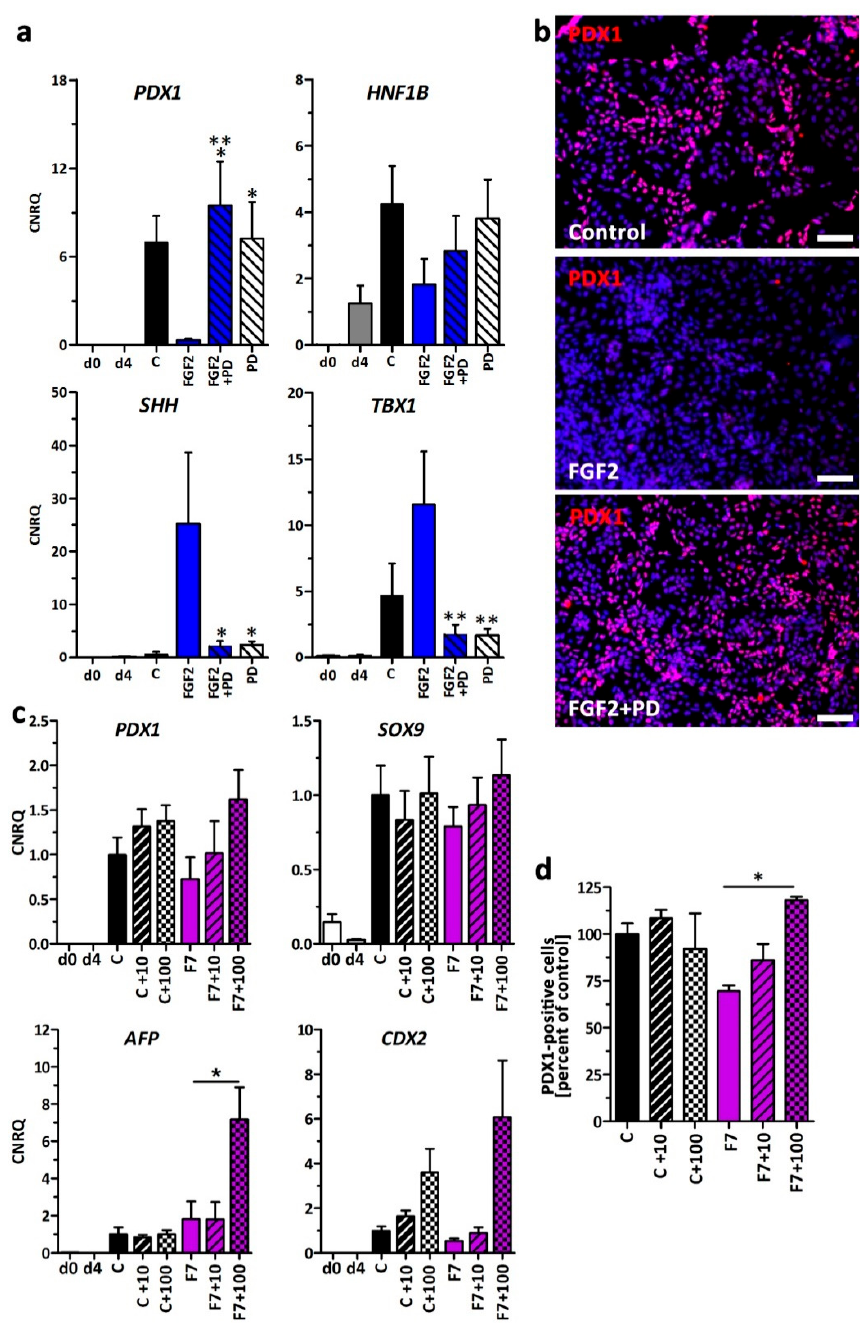
Figure 6. Inhibition of FGFR1c/3c rescues pancreatic development in presence of FGF2 and FGF7. ( a ) Gene expression changes of PDX1 , HNF1B , SHH , and TBX1 in d8 cells treated ± 10 ng/mL FGF2 (F2) and the FGFR1c/3c small molecule inhibitor PD-173074 (PD) with a concentration of 100 nM (PD). Data are means ± SEM, n = 4–5. *** = p ≤ 0.001, ** = p ≤ 0.01, * p = ≤ 0.05 ANOVA plus Tukey’s post-test, F2 treatment compared to F2 + PD and PD only. ( b ) Representative immunofluorescence staining of PDX1 in d8 control cells, cells treated with F2 and F2 + PD. Nuclei were counterstained with DAPI. Scale bar = 100 µm. ( c ) Gene expression changes of PDX1 , SOX9 , AFP , and CDX2 in d8 cells treated ± 50 ng/mL FGF7 (F7) and ± PD-173074 with a concentration of 10 or 100 nM (10, 100). Values are means ± SEM, n = 3–6, * = p ≤ 0.05, ANOVA plus Tukey’s post-test. ( d ) Quantification of PDX1-positive cells at d8 upon treatment ± 50 ng/mL FGF7 and ± PD-173074 with a concentration of 10 or 100 nM. Percentages are expressed as means ± SEM. * = p ≤ 0.05, ANOVA plus Tukey’s post-test.